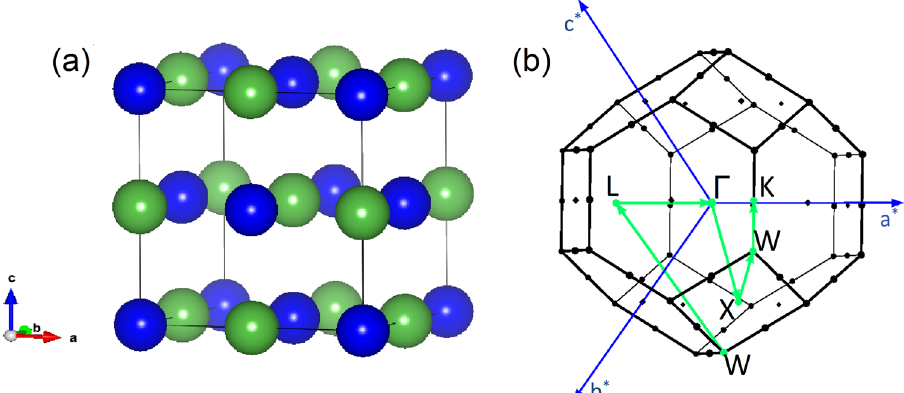
Figure 1. ( a ) The FCC unit cells of LaSb or LaBi. The green spheres denote the La atoms and the blue spheres are the Sb or Bi atoms. ( b ) FCC bulk Brillouin zone. a * , b * , c * denote the reciprocal lattice vectors.